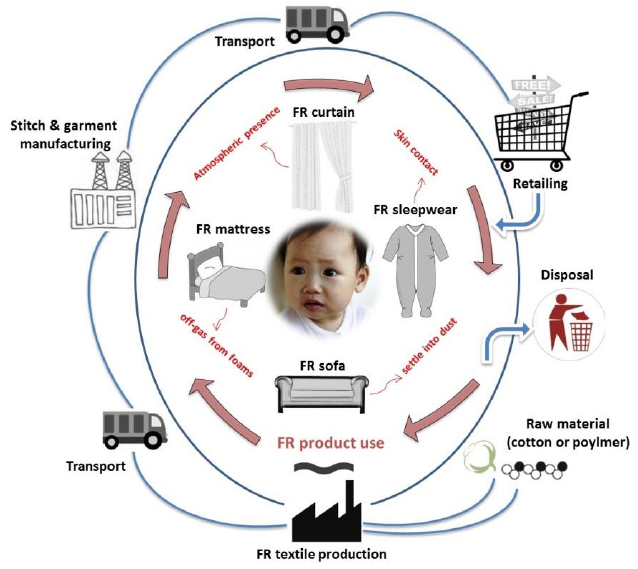
Figure 1. Life cycle of flame retardant (FR) textile products.